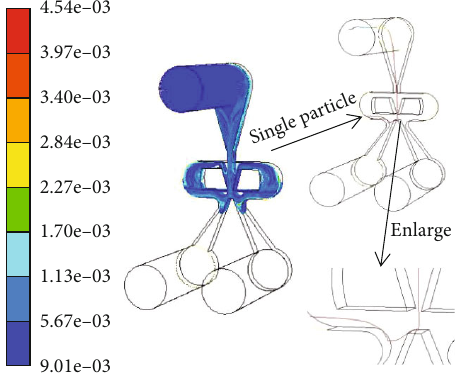
Figure 12: The particle trajectory of the pilot stage.